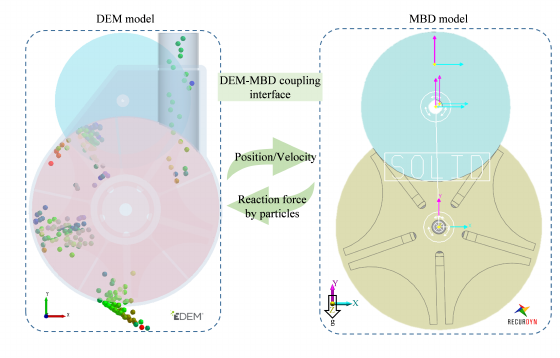
Fig. 3. Schematic diagram of DEM-MBD coupling frame.